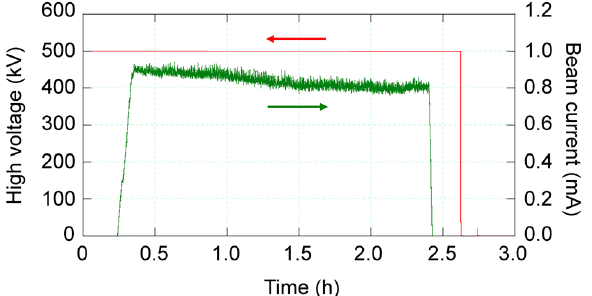
FIG. 15. Operational status of the gun during beam generation at > 0 . 8 mA. The red and green curves show HV and the beam dump current, respectively, as a function of